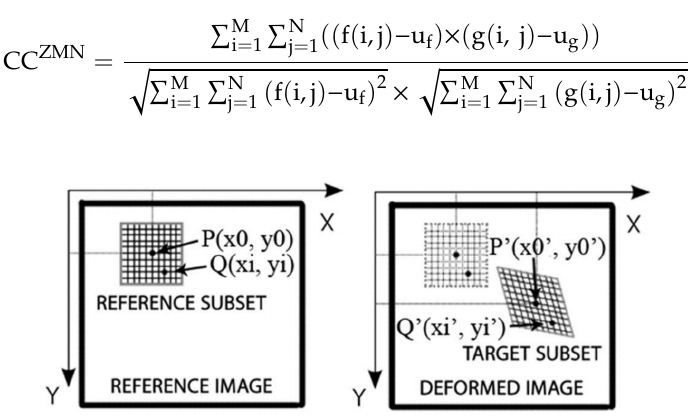
Figure 1. Image subsets before and after deformation [14].